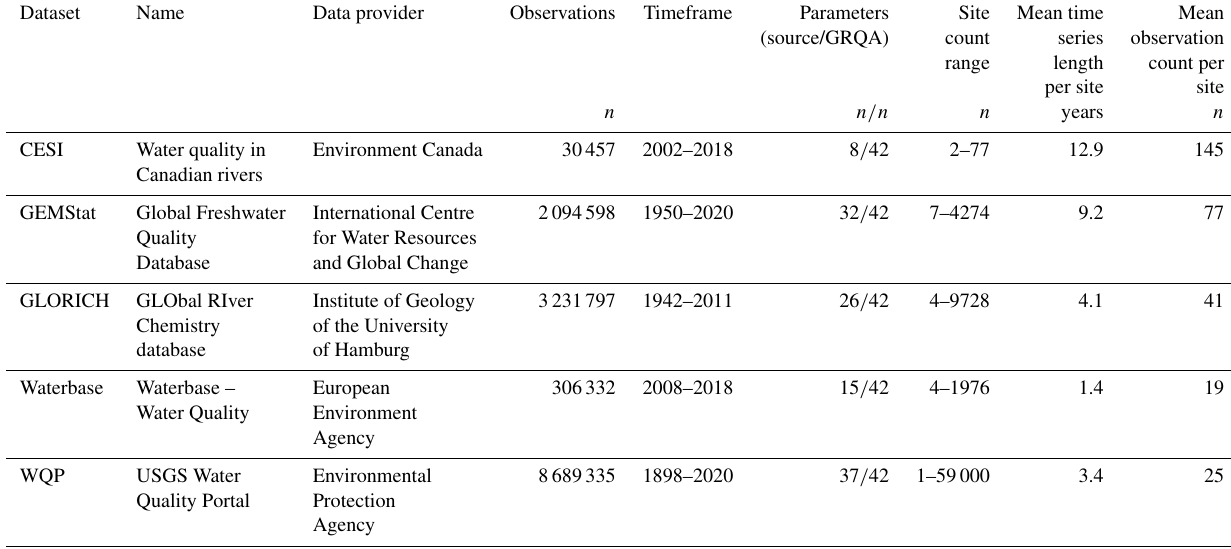
Table 1. Source datasets used for compiling GRQA with their total number of observations, parameters and timeframe length in GRQA. All datasets were retrieved on 16 November 2020.